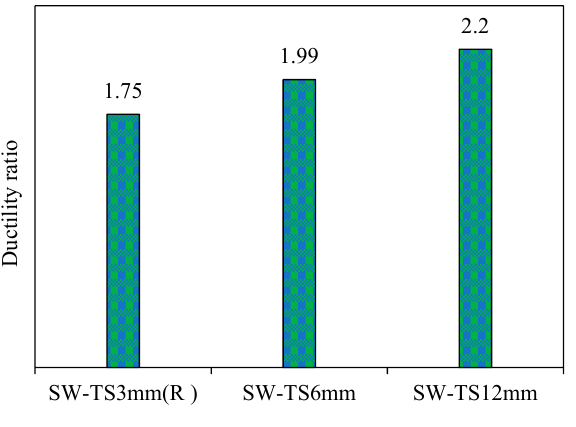
Figure 17. Ductility ratio of group 2.